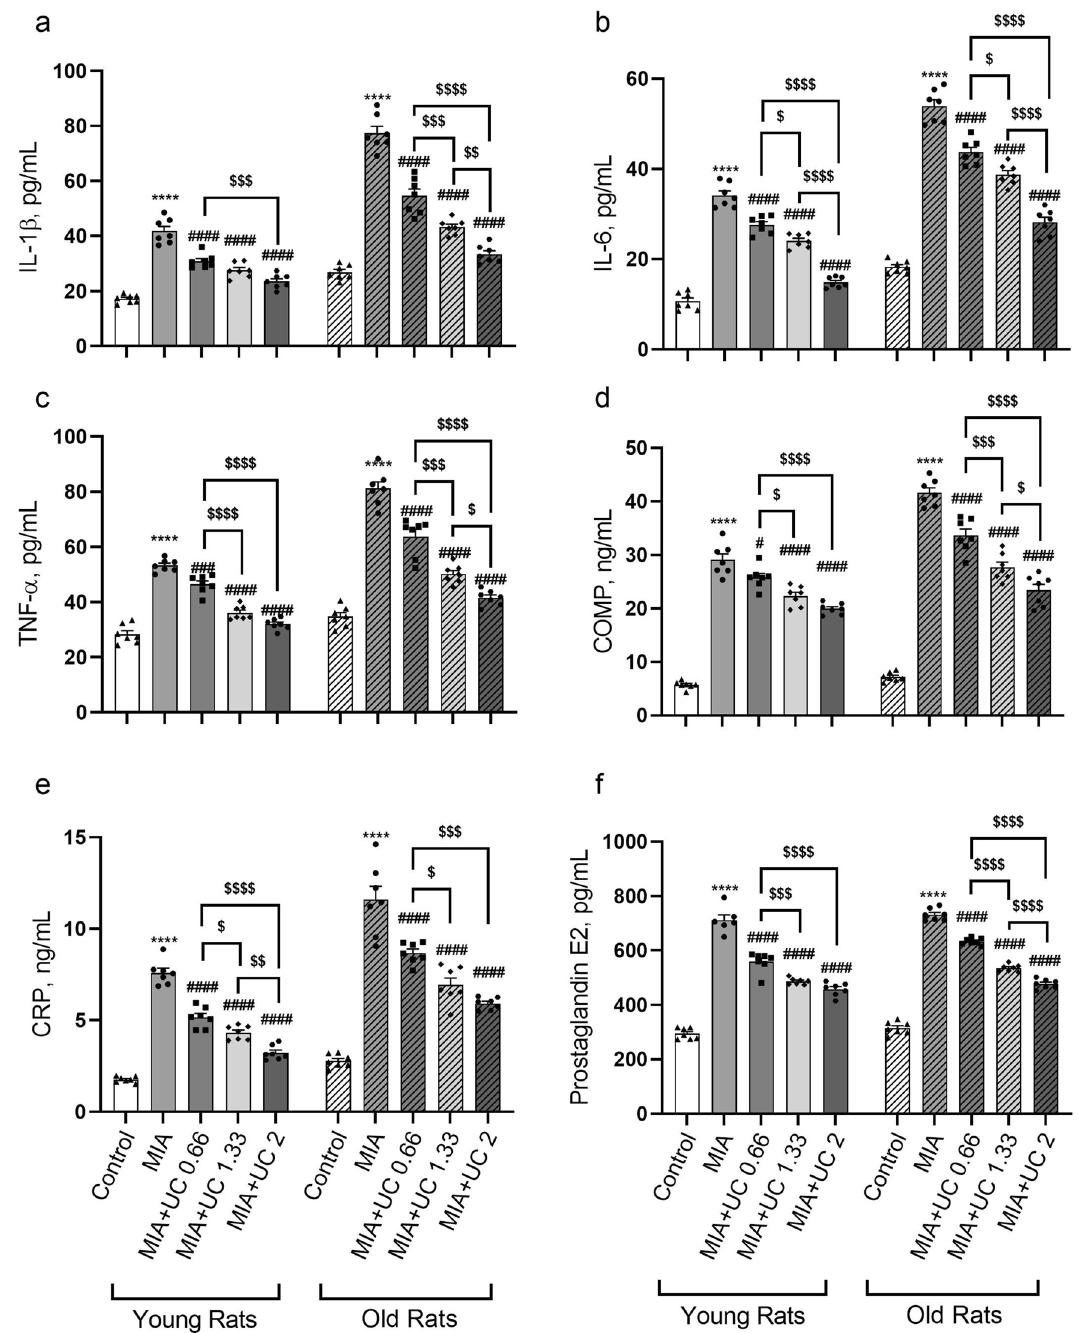
Figure 5. Effects of undenatured collagen (UC) supplementation at different doses on serum IL-1β ( a ), IL-6 ( b ), TNF-α ( c ), COMP ( d ), CRP ( e ), and prostaglandin E2 ( f ) levels in monosodium iodoacetate (MIA) induced osteoarthritis in young (n = 7) and old rats (n = 7). The bars represent the mean ± standard error of the mean (SEM). ANOVA and Tukey’s post hoc test were used to compare the results among different treatment groups. Statistical analysis was performed separately within each age group. Statistical significance between groups is shown by: **** p < 0.0001 (MIA vs. Control), # p < 0.05; ### p < 0.001; #### p < 0.0001 (MIA vs. UC groups), and $ p < 0.05; $$ p < 0.01; $$$ p < 0.001; $$$$ p < 0.0001 (pairwise comparisons between UC